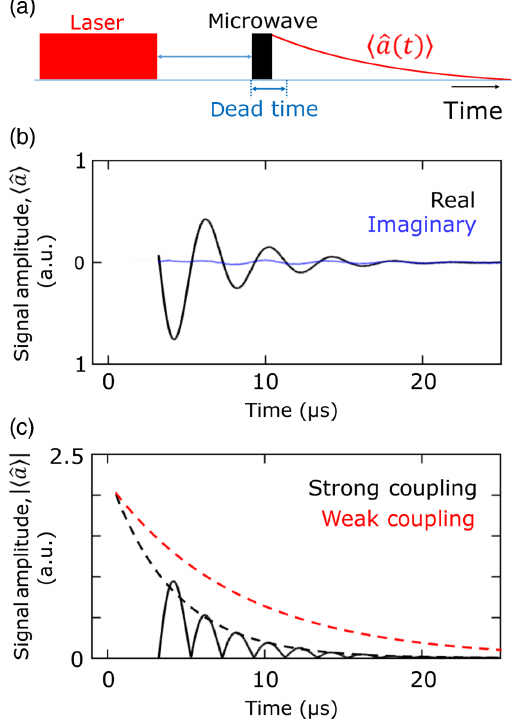
FIG. 3. (a) Pulse sequence of the free-induction decay (FID) experiment. The initial laser pulse sets the number of unpaired spins N and the total spin quantum number S ¼ N= 2 ; the subsequent microwave pulse excites the pseudospin to j S ¼ N= 2 ; M i . The microwave emission from the pseudospin is recorded after the microwave pulse and a 3 - μ s experimental dead time. (b) In-phase Re ð ˆ a Þ and quadrature Im ð ˆ a Þ components of the pseudospin microwave emission during the free-induction decay in the strong-coupling regime ( M ≈ 0 , N ¼ 3 . 6 × 10 13 ). FIG. 2. (a) The number of spins interacting with the resonator (c) Amplitude of the microwave emission j ˆ a j during the ( N ) is controlled by tuning the laser frequency which is FID (black solid line). The FID shows oscillations at rate ffiffiffiffi p spin-selectively exciting a phosphorus donor no-phonon bound ¼ 290 kHz, many coherent cycles of energy exchange g N exciton transition [28]. (b) Reflected microwave power S 11 (color between the spin ensemble and the cavity are resolved. For scale) spectrum of the cavity as a function of the spin-ensemble comparison, the purely exponential decay in the weak-coupling ¼ g μ B 0 ) as the spin ensemble is brought Zeeman splitting ( ω regime is also shown (dashed red line) with g s B into resonance with the bare cavity ( ω ). The clear avoided κ ¼ 960 kHz. The decays are normalized to have the same c crossing shows that the system is in the strong-coupling regime ffiffiffiffi p magnitude at t ¼ 0 N with 2 g (580 kHz) ≫ κ þ γ (64 kHz). (c) The vacuum Rabi ffiffiffiffi p ¼ ω N splitting ( 2 g ) of the polariton modes (shown at ω ) can s c be controlled by detuning the laser frequency. Curves 1 and 2 were measured while the laser frequency was tuned to points 1 and 2 as indicated in (a).